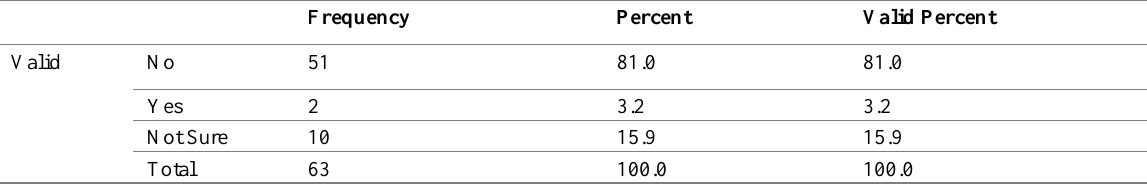
Table 19: Results of Questionnaire Processing Related to Social and Cultural